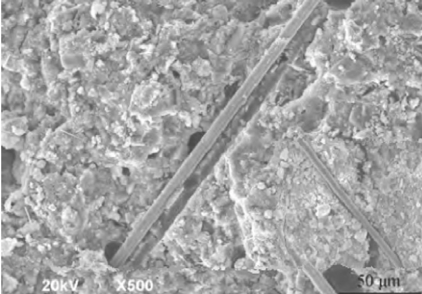
Figure 14: Carbon fiber “reinforced” shedding phenomenon under long-term immersion.